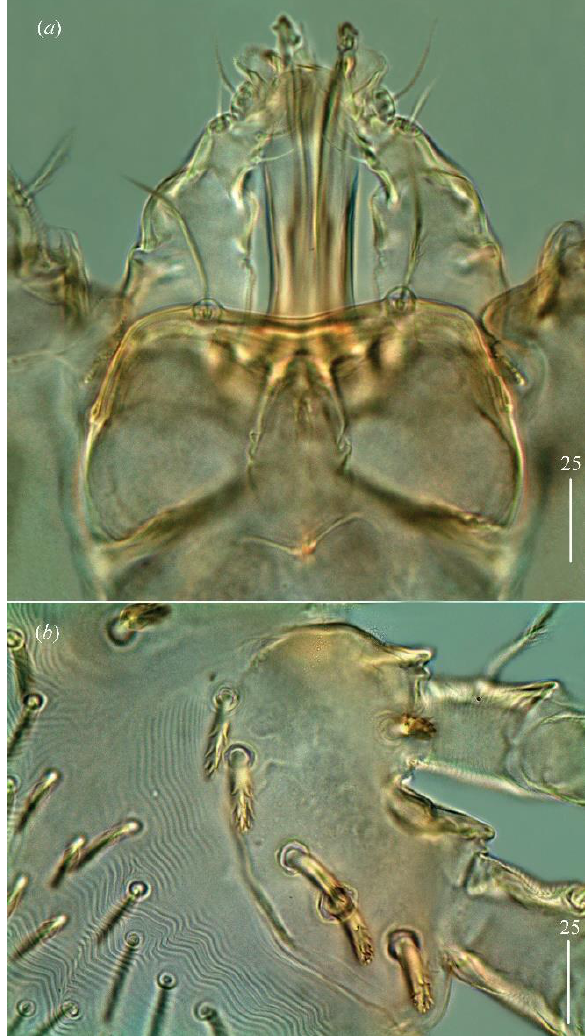
Figure 8. Geckobia mysoriensis sp. n. female, details: ( a ) gnathosoma in ventral view; ( b ) coxae III and IV.